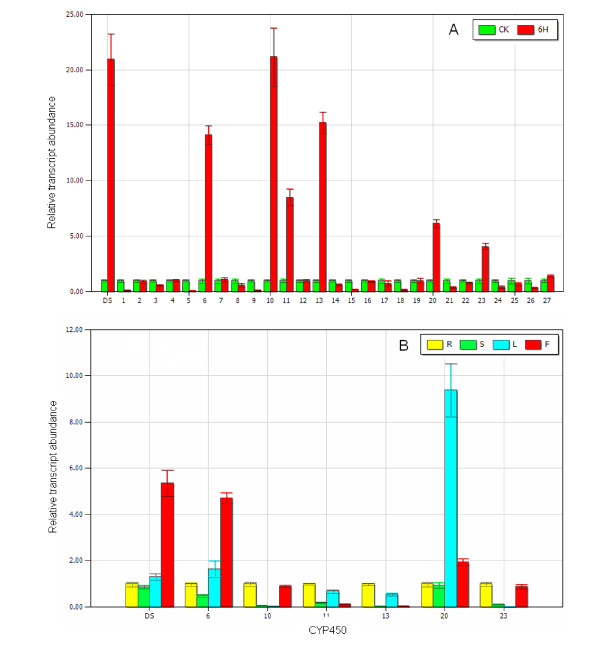
Real time PCR analysis of CYP450s in MeJA-treated materials and different plant tissues. CK represents the uninduced material; 6H represents the material treated for 6 h with MeJA; and DS represents dammarenediol-II synthase. The corresponding contigs represented by numbers 1 - 27 are listed in Additional File 6. A) Changes in the gene expression of CYP450s induced by MeJA. B) The gene expression of CYP450s in different tissues.